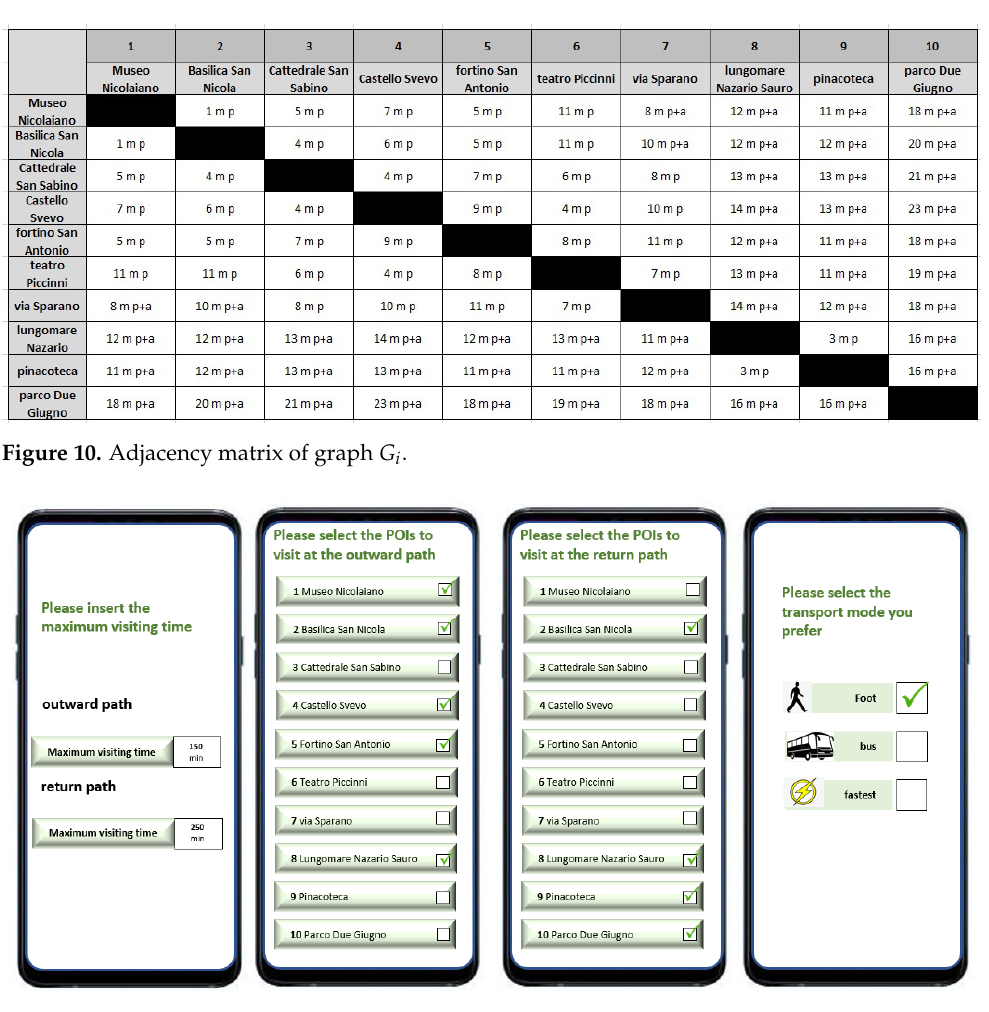
Figure 11. The GUI of the user